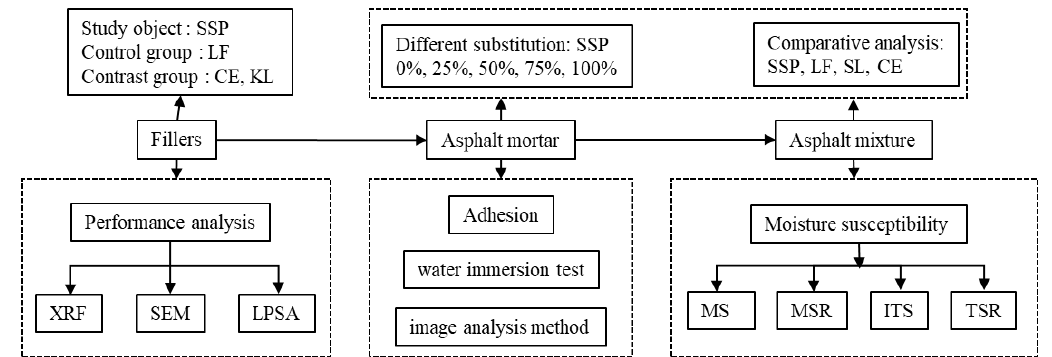
Figure 2. Framework of experiment procedure.